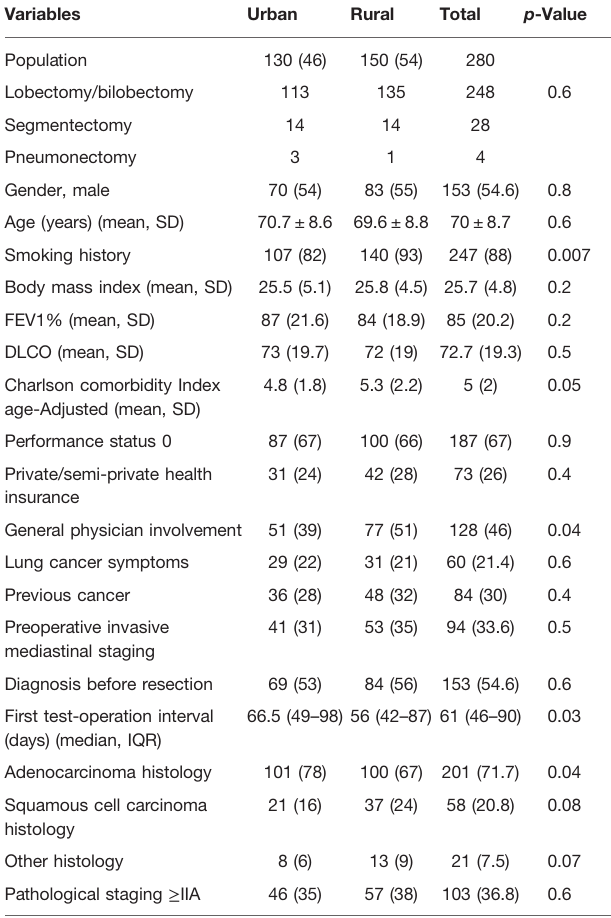
TABLE 1 | Patients ’ characteristics and differences based on the results of univariable